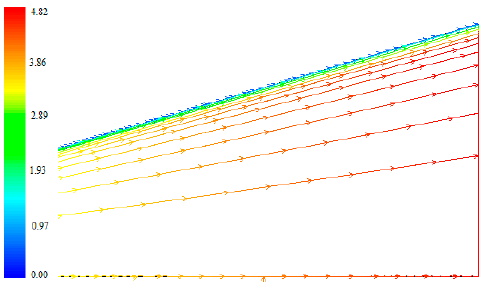
Figure 10. The Mach number streamlines’ map under high-altitude conditions, Pc = 4.34 MPa.